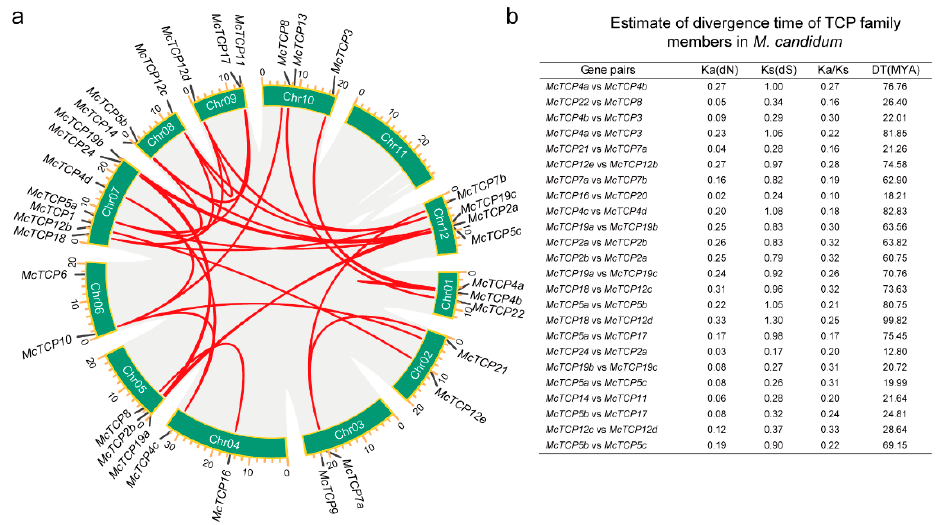
Figure 7. TCP gene pairs within M. candidum . ( a ) circos graph of TCP family members in M . candidum . Red lines within the circos graph represent a gene pair relationship. ( b ) Divergence time estimation of TCP gene pairs. Ka means non-synonymous substitution rate; Ks means synonymous substitution rate; DT means divergence time.